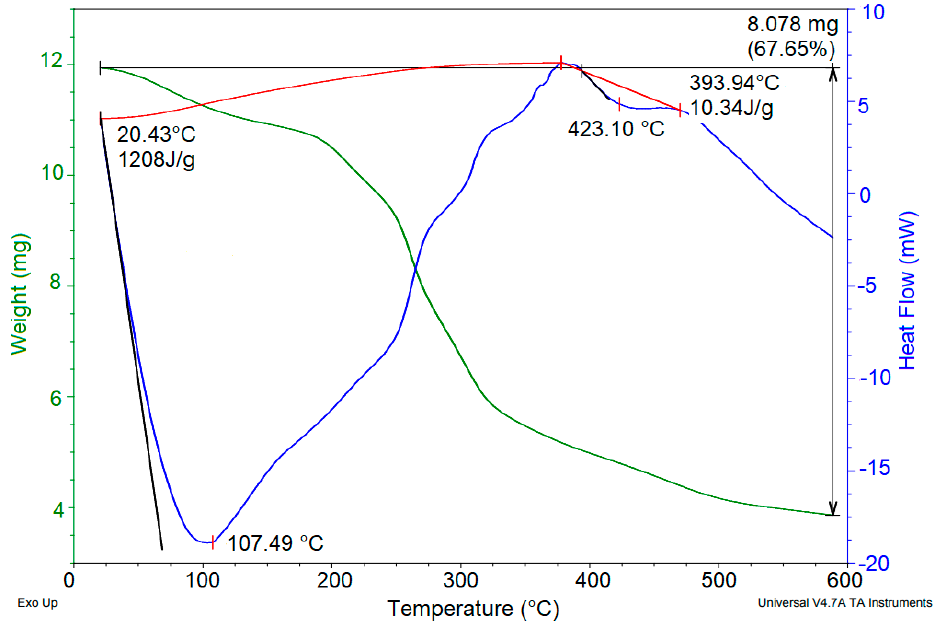
Figure 7. TGA/DSC thermograms of powdered mucilage from Opuntia ficus-indica fruit peel.